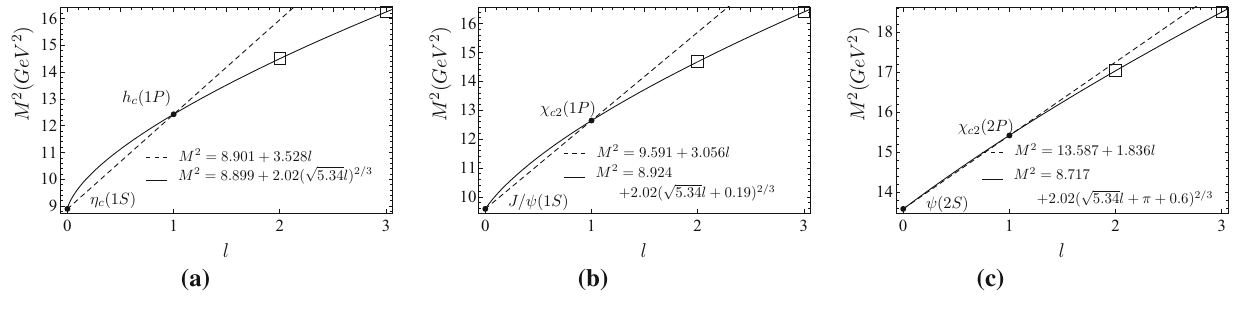
Fig. 6 Radial Regge trajectories for charmonia. The well-established states are given by solid dots and the candidate states are given by circles. Open squares are predicted masses by the fitted Regge trajectories